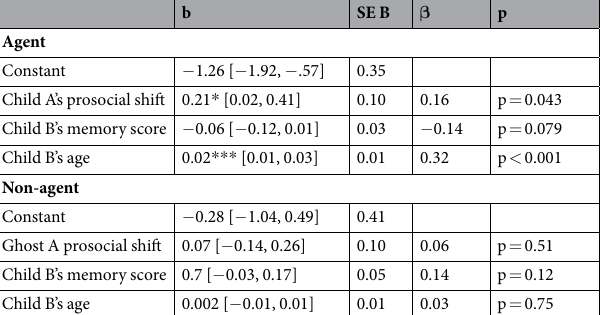
Table 2. Linear predictors of B’s prosocial shift from test to retest in the agent and non-agent conditions [95% BCa bootstrap confidence intervals based on 1000 samples]. Note. Agent R² = 0.17, Model F(3) = 9.80, p < 0.001. Note. Non-agent R² = 0.03, Model F(3) = 1.24, p = 0.30. Note. * p < 0.05; *** p <